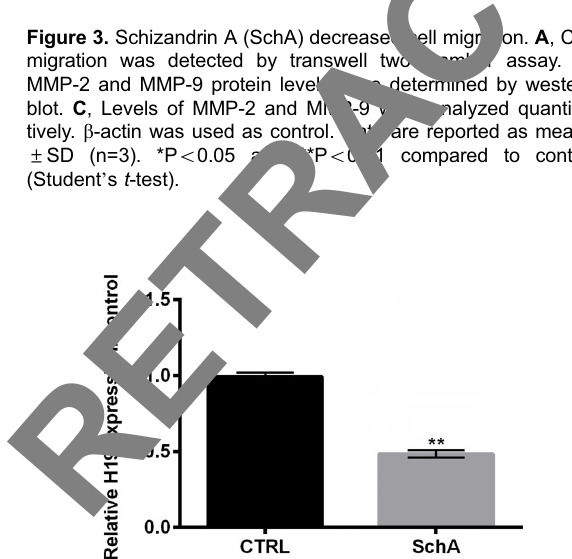
Figure 4. Schizandrin A (SchA) down-regulated H19 in A375 cells via qRT-PCR. Data are reported as means ± SD (n=3). **P o 0.01 (Student ’ s t -test).